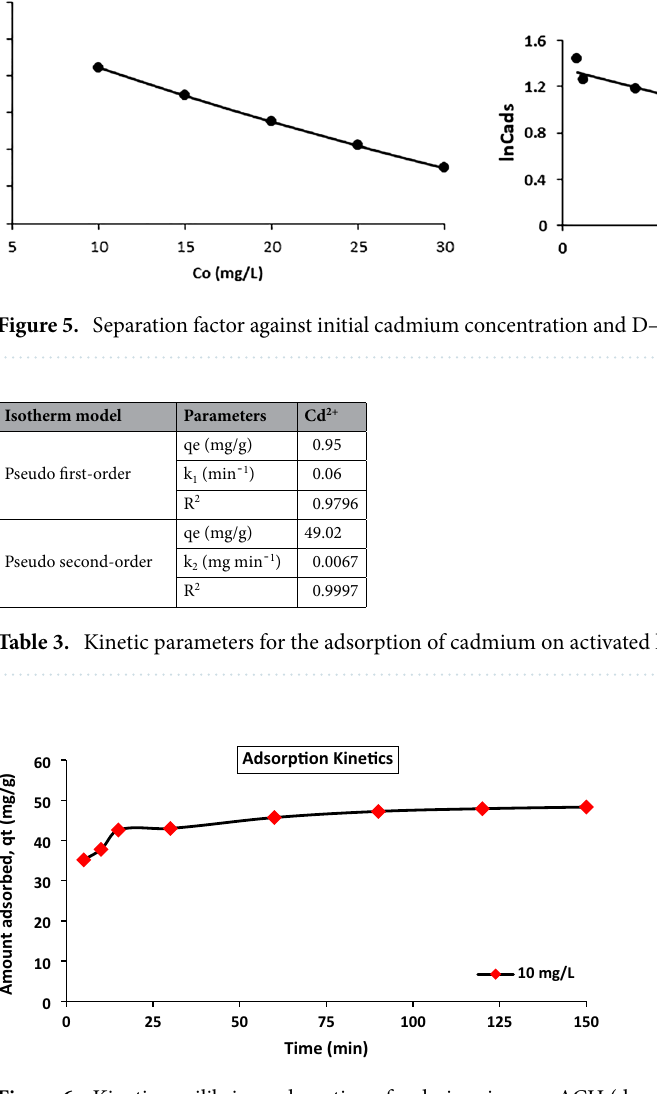
Figure 6. Kinetic equilibrium adsorption of cadmium ions on ACH (dose 0.03 g, cadmium conc. of 10